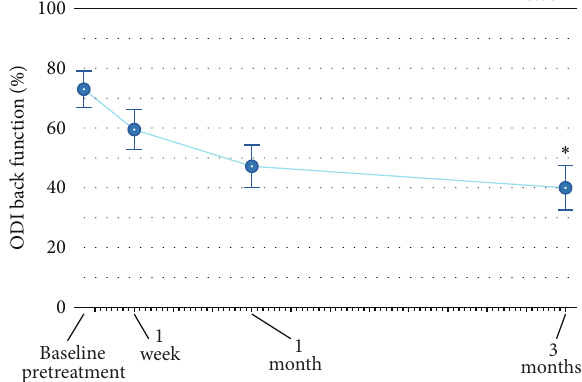
Figure 4: Improvement in back function through 3 months fol- lowing radiofrequency-targeted vertebral augmentation. Values are mean ± 95% confidence intervals. ODI: Oswestry Disability